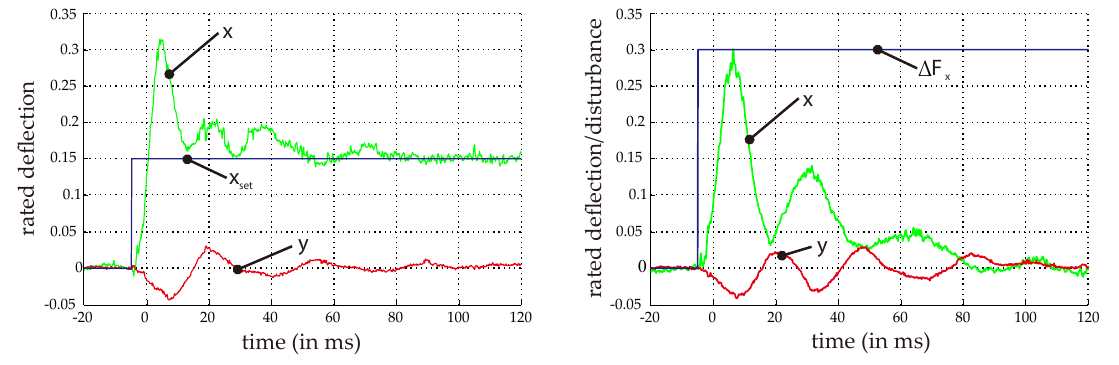
Figure 14. Reactions of the x - and y -positions following a step in the set-point value ( left ), and a step change in the suspension force ( right